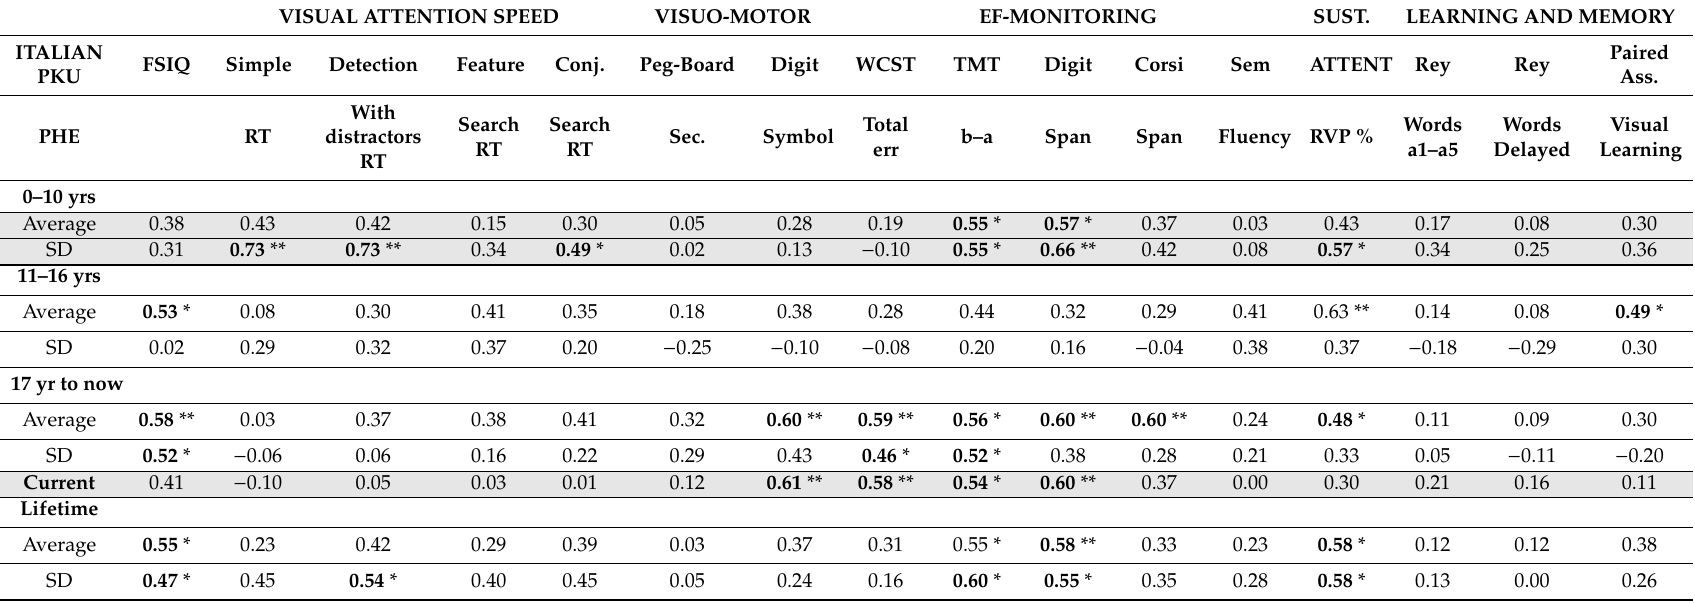
Table 4. Correlations Between Phe Measures Across the Life-Span and Cognitive Performance in Di ff erent Domains for the Italian PKU Sample ( N = 19). VISUAL ATTENTION SPEED VISUO-MOTOR EF-MONITORING SUST. LEARNING AND MEMORY